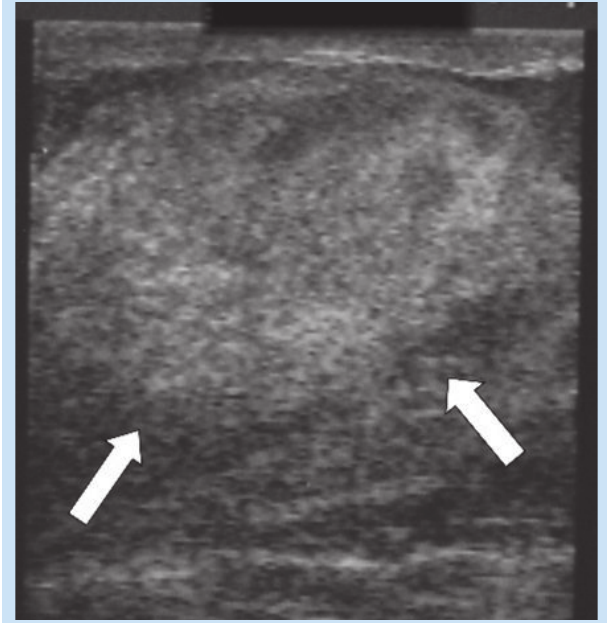
Fig. 2. US. Well-outlined area of increased echogenicity. No spiculae. No calcifications. No increased flow on colour